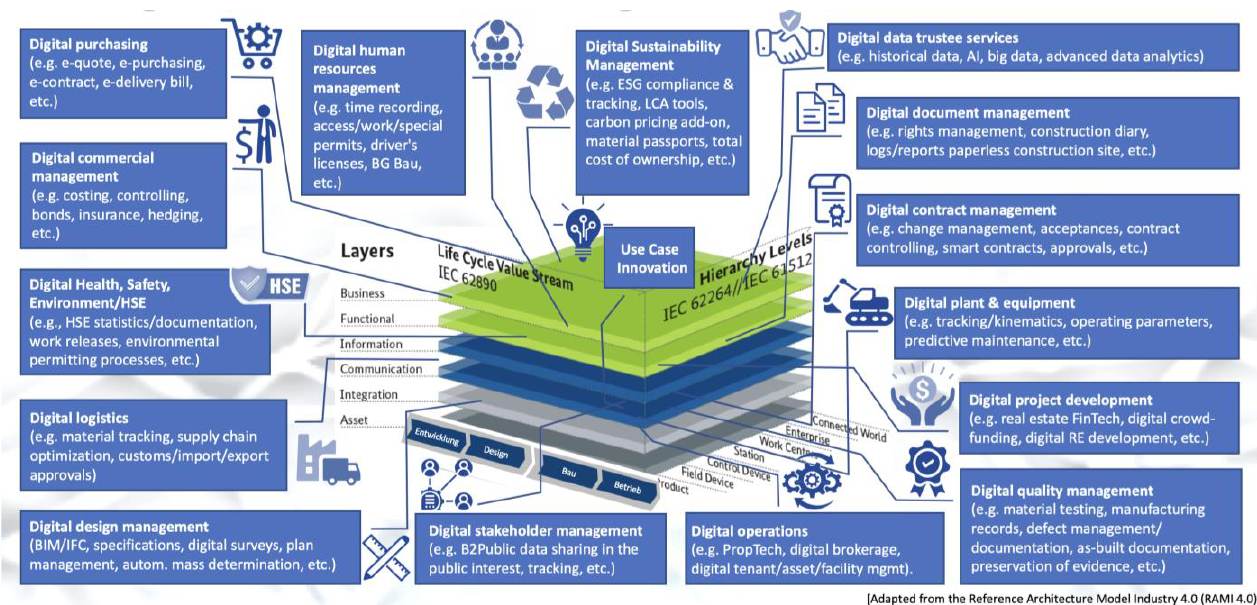
Figure 7. Exemplary use cases of a data cooperative: digital interfaces, data exchange formats and structure, adapted from the Reference Architecture Model Industry 4.0 (RAMI 4.0, reprinted with permission of [68]) .